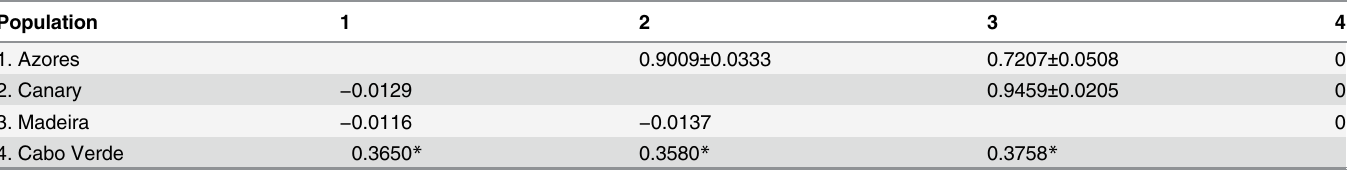
Table 2. F ST estimations from pairwise comparisons among the populations of Macaronesian Megabalanus azoricus sampled using the mitochon- drial control region data.